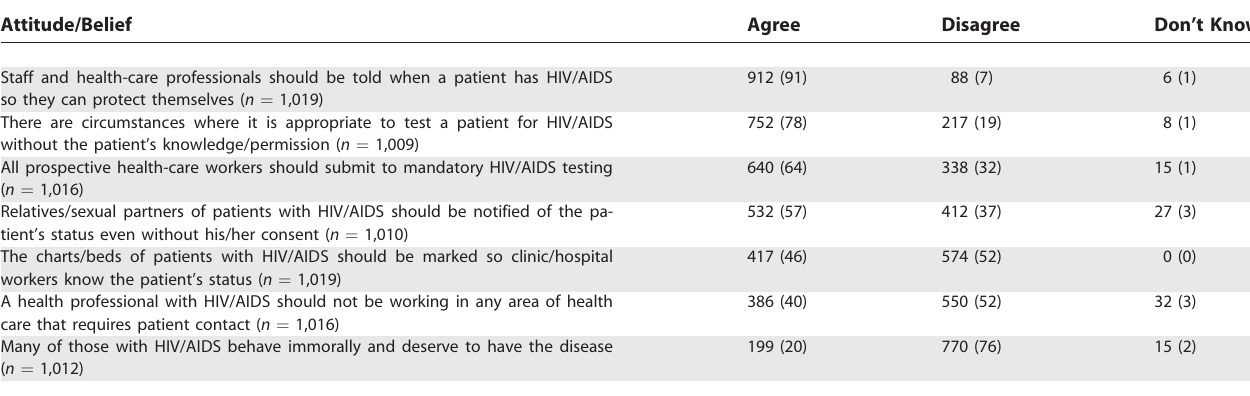
Table 4. Provider Attitudes and Beliefs about HIV Testing, Consent, and Disclosure Attitude/Belief Agree Disagree Don’t